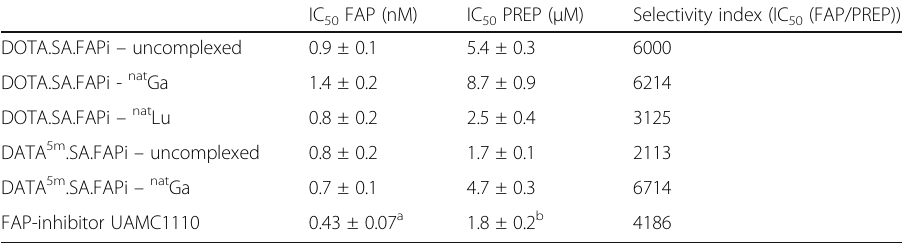
Table 1 IC 50 -values of DOTA.SA.FAPi, the nat Ga and nat Lu-complexes and DATA 5m .SA.FAPi and the nat Ga-complex with regard to FAP and PREP. Selectivity index gives the ratio FAP to PREP IC 50 FAP (nM) IC 50 PREP ( μ